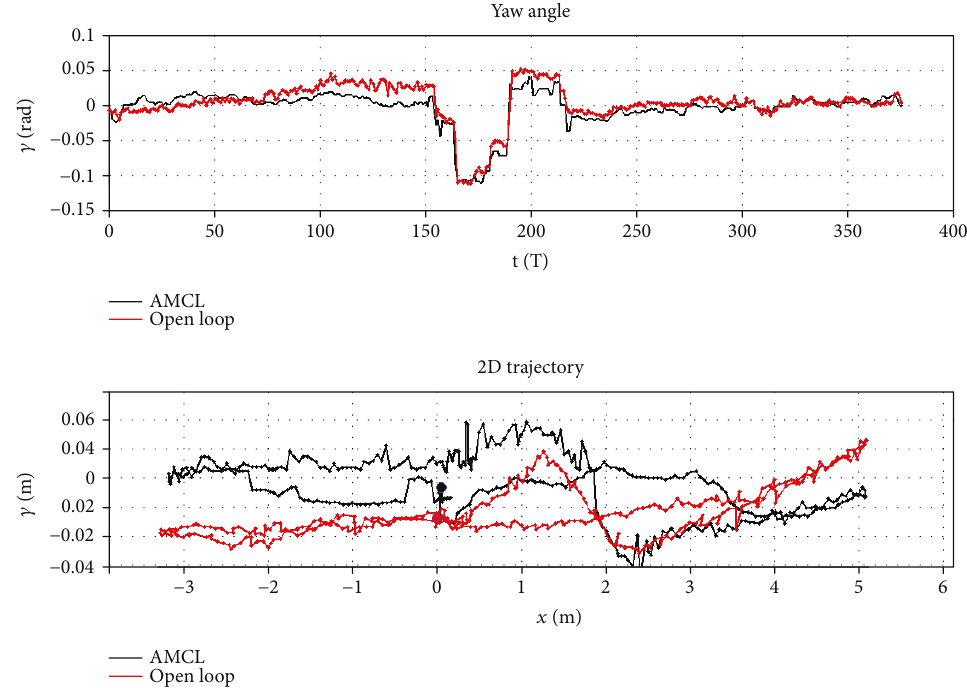
Figure 10: Trajectory of straight line round-trip motion experiment. Table 2: Result of closed-loop motion experiments (open-loop version). Corresponding Robot Error of original AMCL Origin ’ s pose